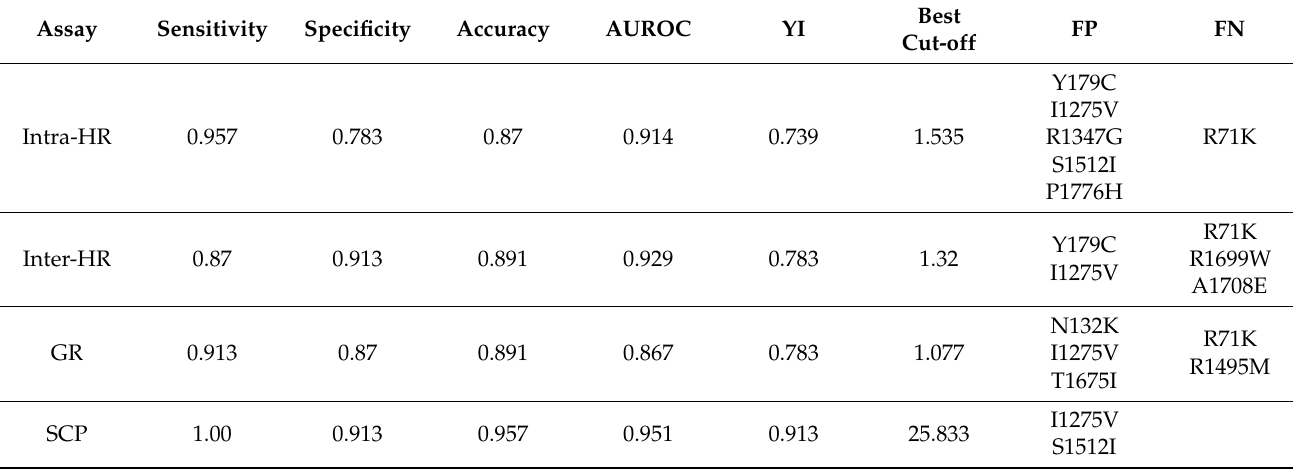
Table 1. Performance evaluation and reliability of yeast-based assays.